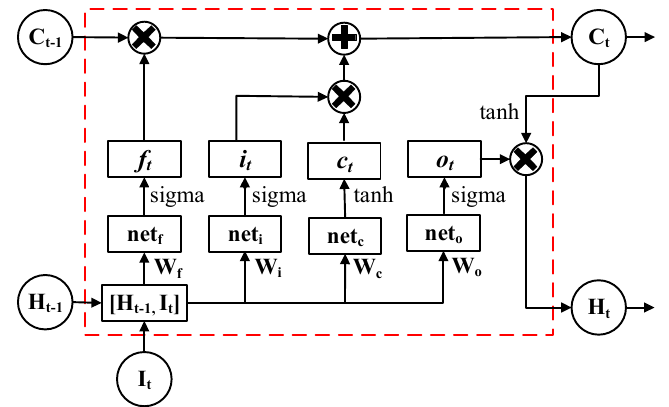
Figure 4. Architecture of the LSTM memory block.